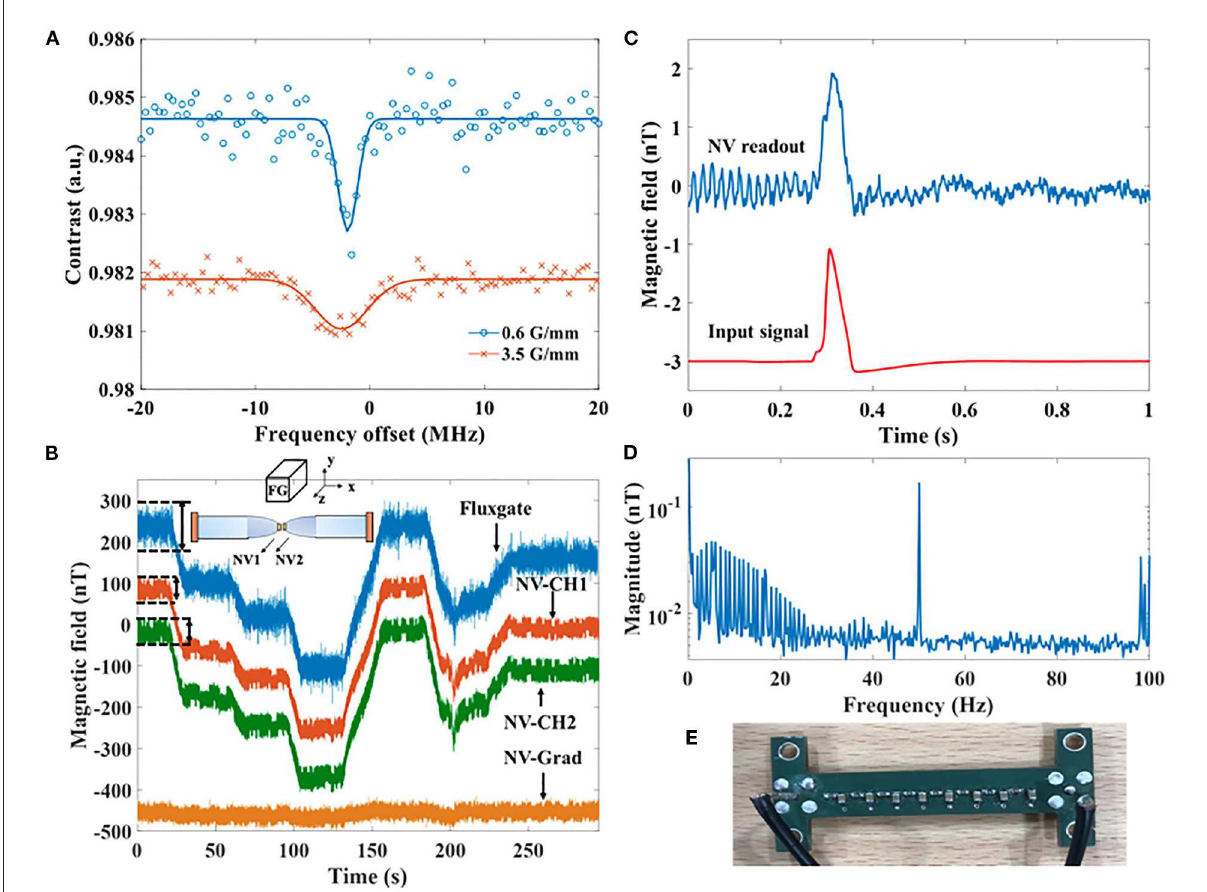
FIGURE5 (A) ODMR spectra with different local gradients at the diamond. (B) Magnetic field detected by the NV gradiometer in the unshielded environment with the comparison of a fluxgate magnetometer. The schematic of the setup is shown as the inset drawing. The step signals are generated by an elevator nearby. From top to bottom, the lines are signals from the fluxgate sensor, NV gradiometer channel 1 and channel 2, and the output of the NV gradiometer, i.e., subtraction of the two channels. The dashed lines and arrows are the eye-guide for comparing the noise of NV channels and the fluxgate magnetometer. (C) The action potential signal (generated by a phantom) detected by the NV magnetometer. The original input of the action potential is as the lower waveform shows. The detected magnetic field amplitude is about 2 nT. (D) is the Fourier transform of the detected action potential signal. The principle noise peaks are at dc, 50 Hz, and 100 Hz. (E) The phantom used for generating magnetic field signals to simulate the MMG